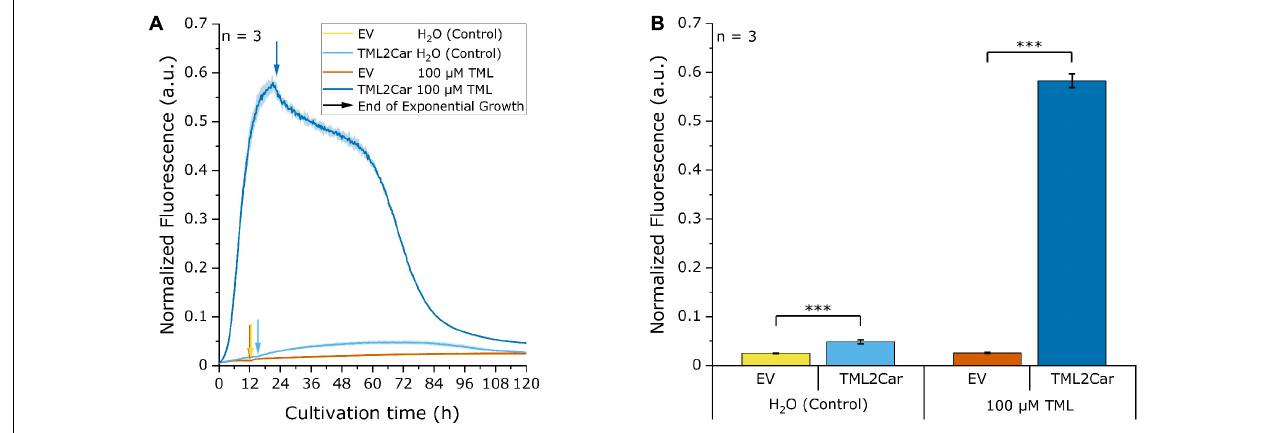
FIGURE 5 | Biosensor experiment with the synthetic L -carnitine biosynthesis pathway operon. The pathway genes were cloned in the order of the respective reaction steps into pECXT99A resulting in plasmid pECXT99A-TML2Car and tested in the L -carnitine biosensor strain E. coli (cid:49) cai-fix (pGP2-Sensor1- caiCD ). The empty vector (EV) of pTrc99A was used as a control. In the cultivation, either 100 µ M TML was supplemented, or water was used as control. (A) Development of the normalized fluorescence signal over the cultivation process. The yellow (EV, H 2 O) and orange lines (EV, 100 µ M TML) are largely overlapping. The end of the exponential growth phase and transition to the stationary growth phase is marked with arrows for each condition. (B) Analogous to the previous readouts, the maximum normalized fluorescence signal for each cultivation was extracted from (A) and analyzed for significance of values between TML2Car and the respective EV control. Error bars indicate the standard deviation of the mean of three replicates. Three asterisks ( ∗∗∗ ) indicate a p -value ≤ 0.001 in a student’s t